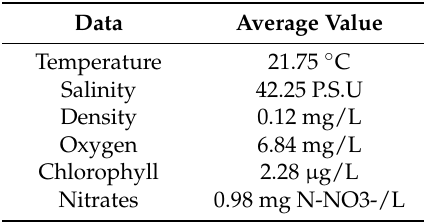
Figure 15. Sonar image of the actual route of the vehicle in Box 102 superimposed on the route setpoint trace. Representation in HMI of IUNO. Table 5. Average parameter values in Box